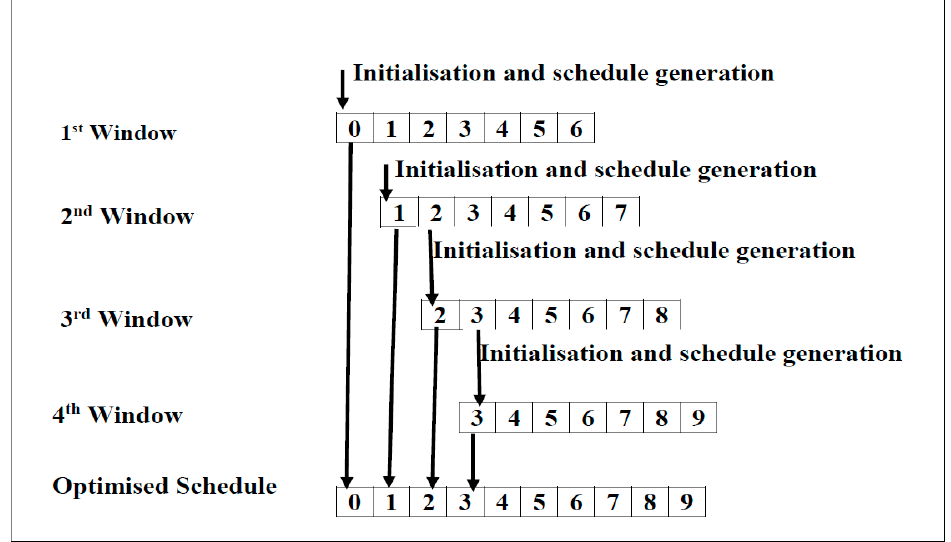
Figure 1. Sliding Time Window